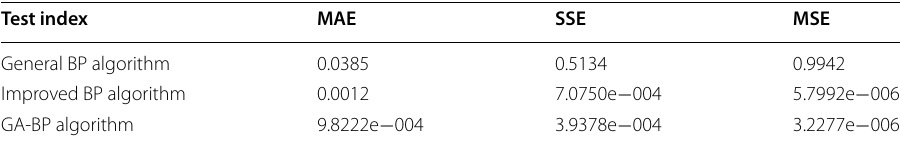
Table 1 Comparison results of three